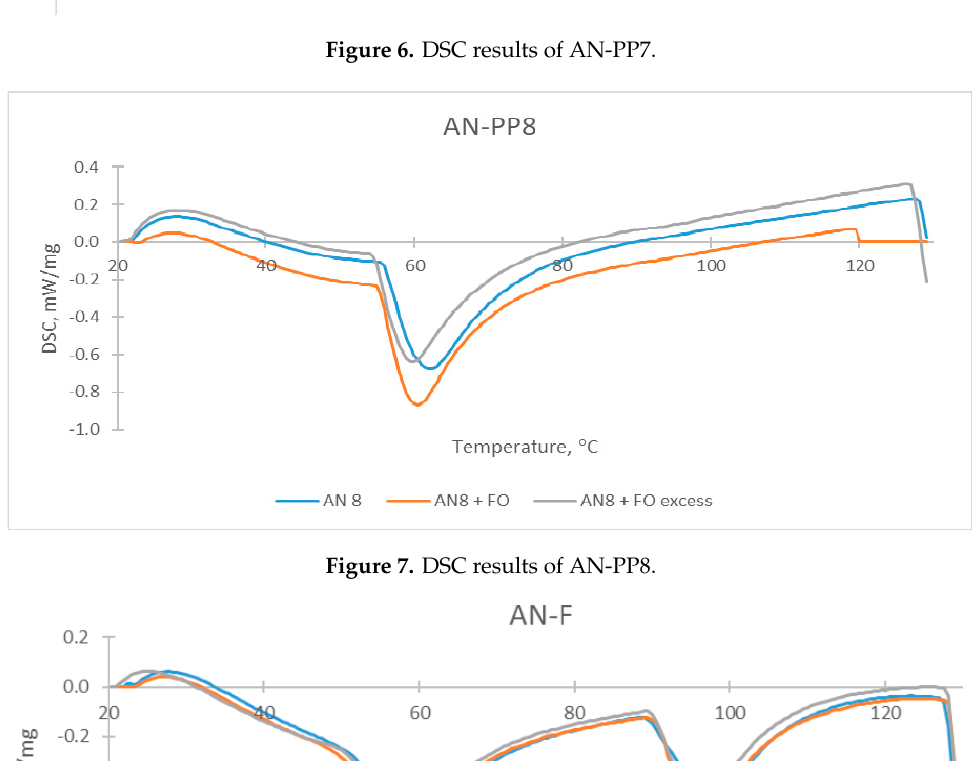
Figure 6. DSC results of AN-PP7.